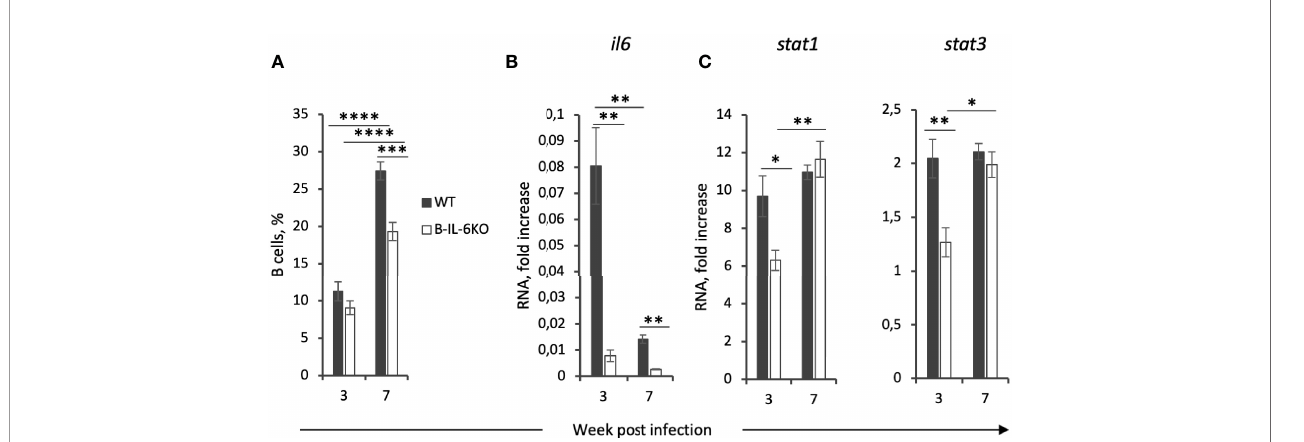
FIGURE 3 | Lung B-cells are a major source of IL-6 which regulates their accumulation and the expression of IL-6-dependent stat3 and IFN- g -dependent stat1 genes in the lung tissue at the early phase of infection. (A) The total percentile of CD19 + B-cells in the lungs of B-IL-6KO and WT mice at weeks 3 and 7 post infection, revealed by fl ow cytometry. (B, C) qPCR evaluation of the levels of il6 , stat1 and stat3 mRNAs in the lung tissue at weeks 3 and 7 post infection. Gene expression was normalized to that of hprt . Results of one of two similar experiments are displayed as mean ± SD, 4-5 mice per group per time-point. * P < 0.05; ** P < 0.01; **** P <